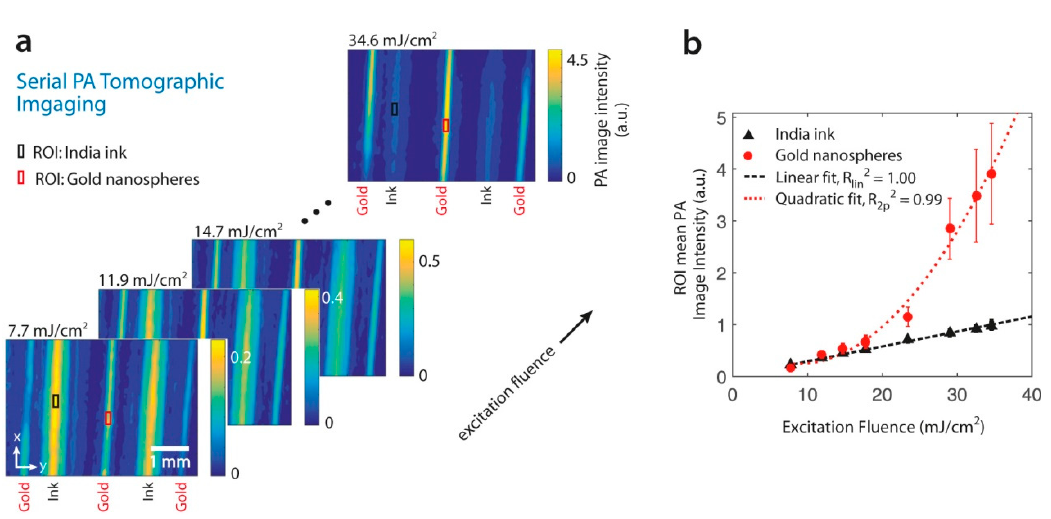
, is plotted in lin